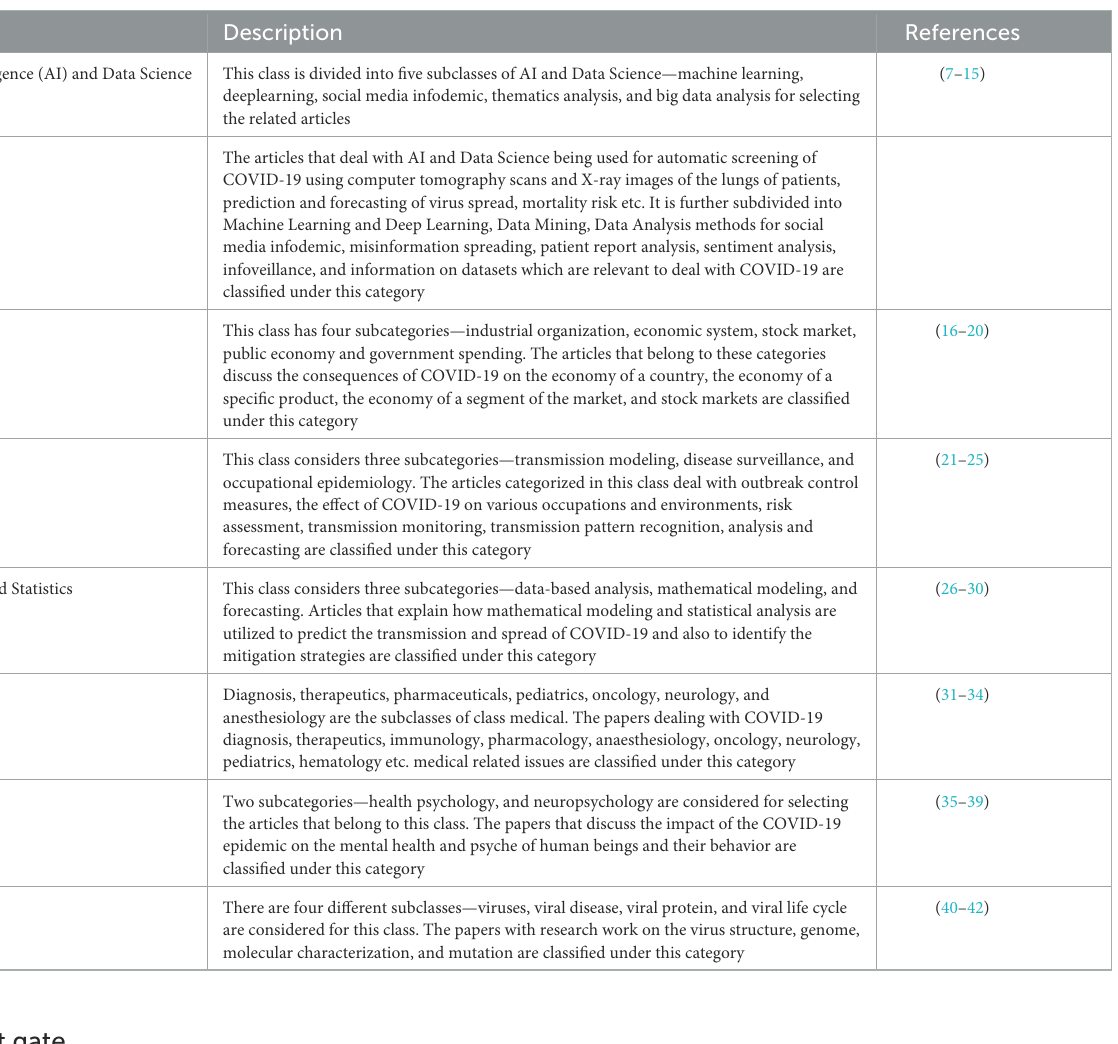
TABLE 1 A description of class labels